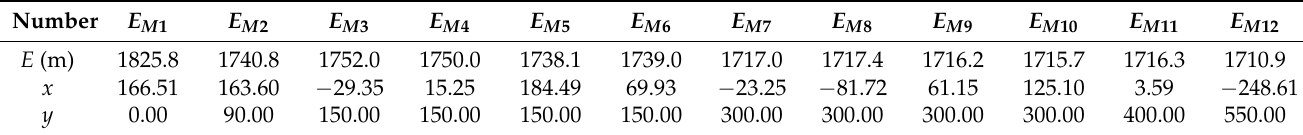
Table 2. Drilling water head E M in the geological